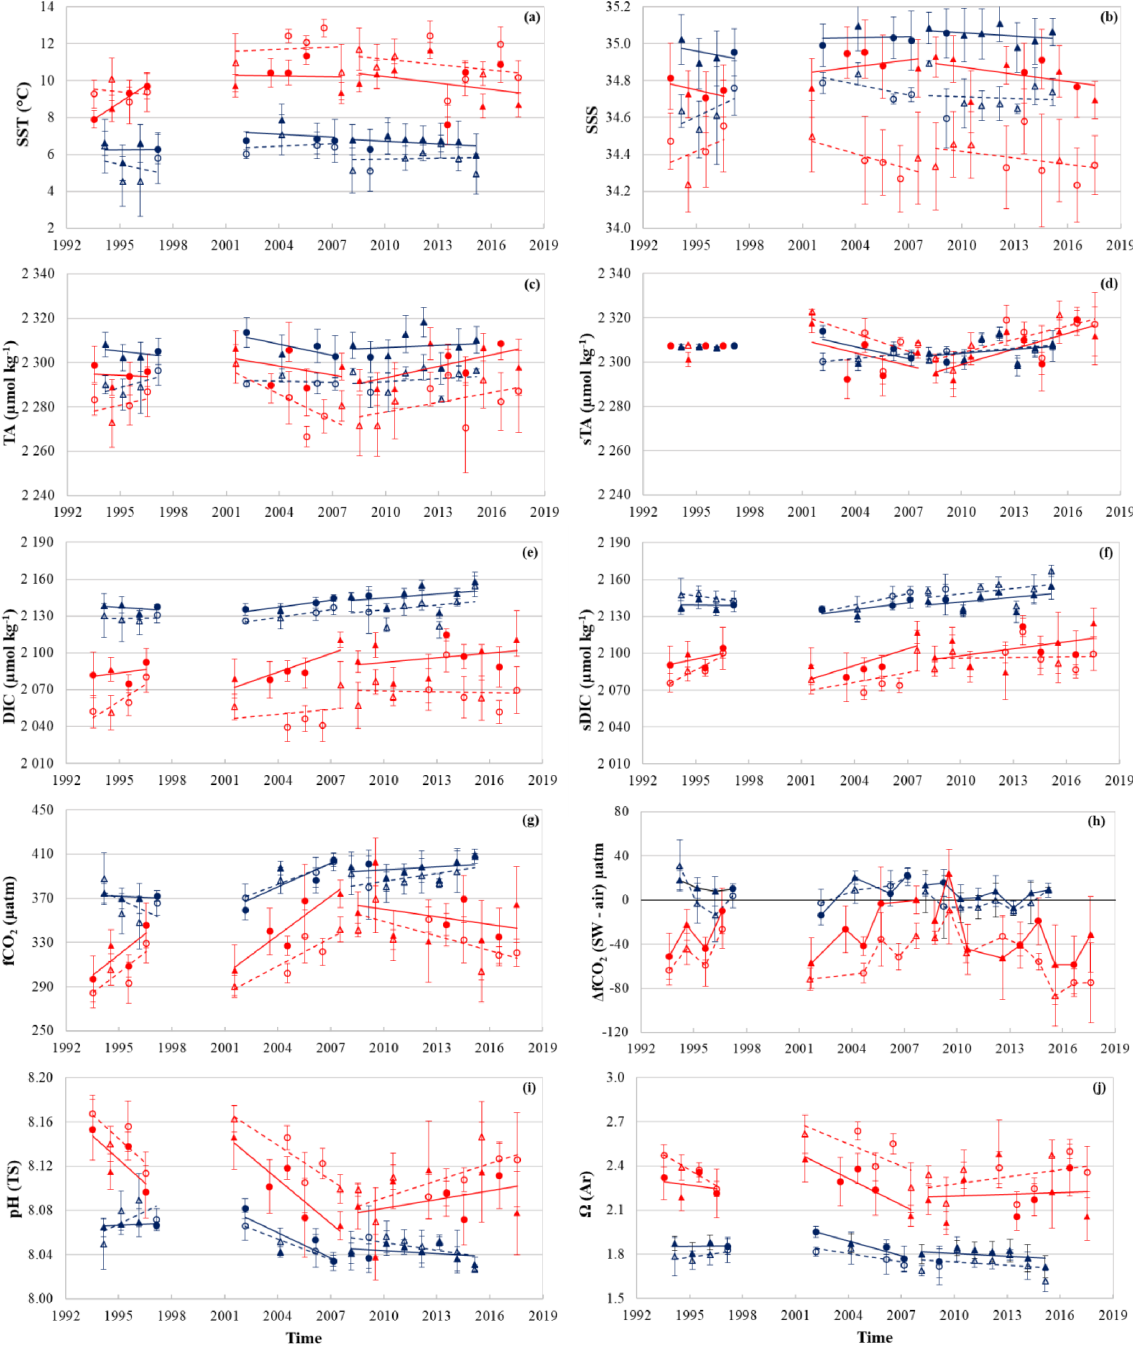
Figure 4. Evolution of (a) SST, (b) SSS, (c) TA, (d) sTA, (e) DIC, (f) sDIC, (g) f CO 2 , (h) (cid:49)f CO 2 , (i) pH and (j) (cid:127) Ar between 1993 and 2017 is obtained in box B (open symbols) and by combining all data in boxes C, D and E (filled symbols) during summer (in red) and winter (in blue). Data from February and July are indicated with circles, and the reconstructed data are depicted with